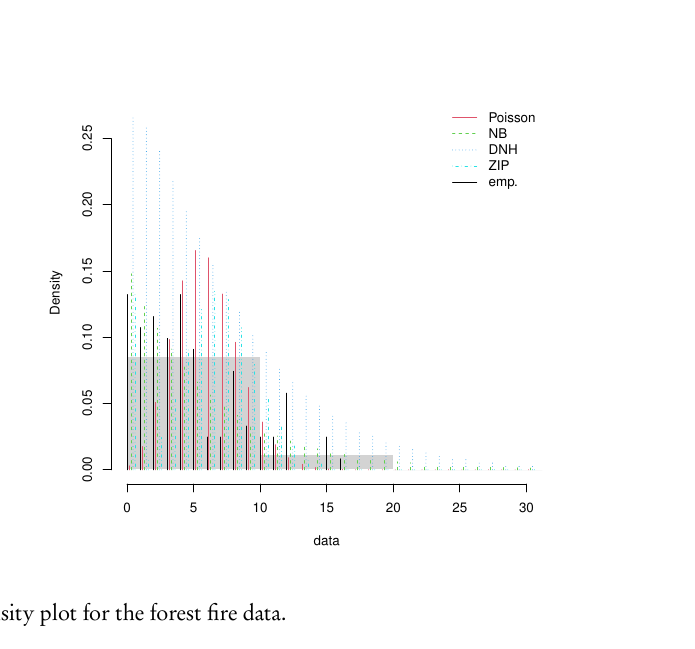
Figure 4 – Density plot for the forest fire data.